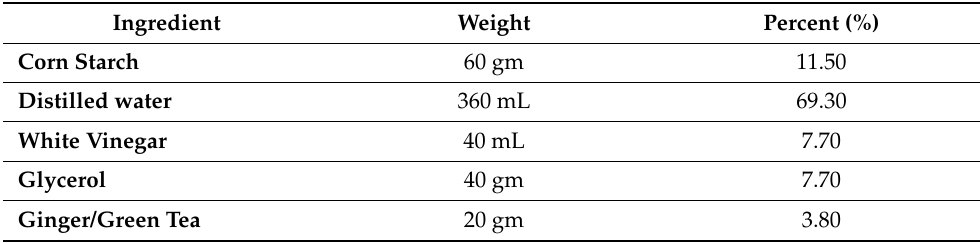
Table 1. Composition of different ingredients used to fabricate the bioplastic samples. Ingredient Weight Percent (%) Corn Starch 60 gm 11.50 Distilled water 360 mL 69.30 White Vinegar 40 mL 7.70 Glycerol Ginger/Green